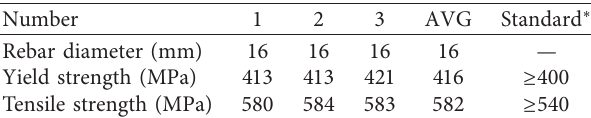
Figure 1: Simplified diagram of half-grouted sleeve (unit: mm). Table 1: HRB400 rebar base material testing data.